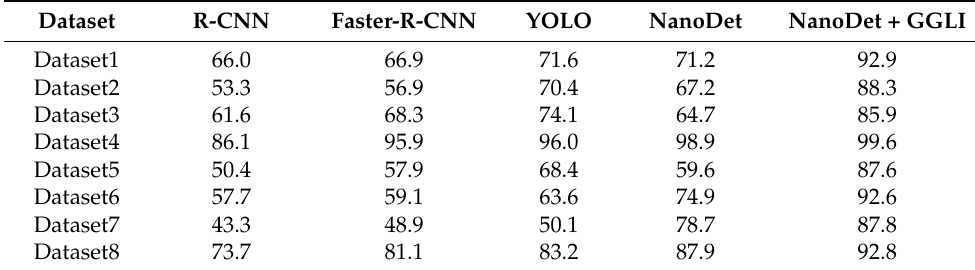
Table 1. Comparisons of OA values using Faster-R-CNN, YOLO, NanoDet, and our